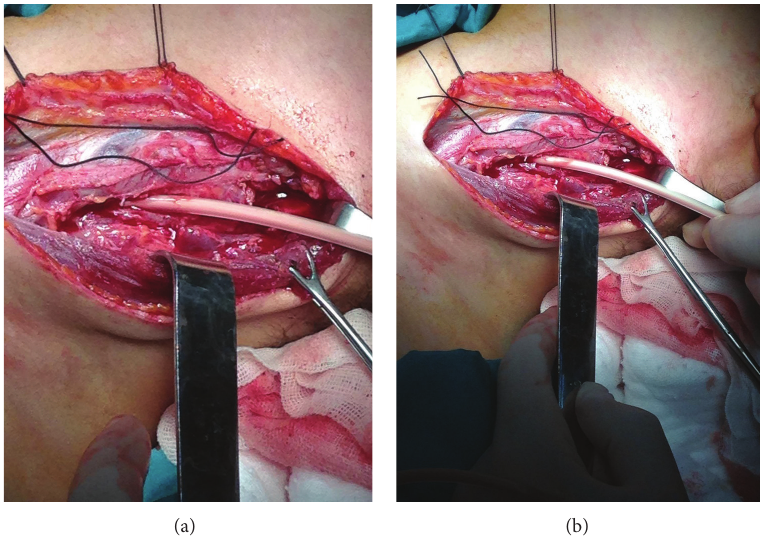
Figure 2: Peroperative images of the patient during the surgical abscess drainage